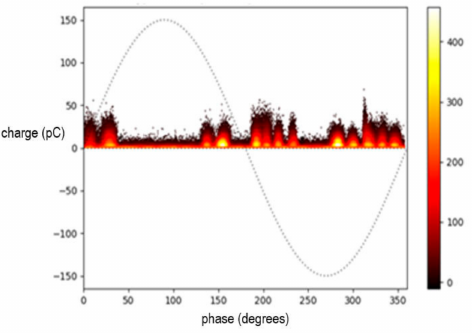
Figure 3. A phase resolved partial discharge analysis (PRPDA) example of simulated noise